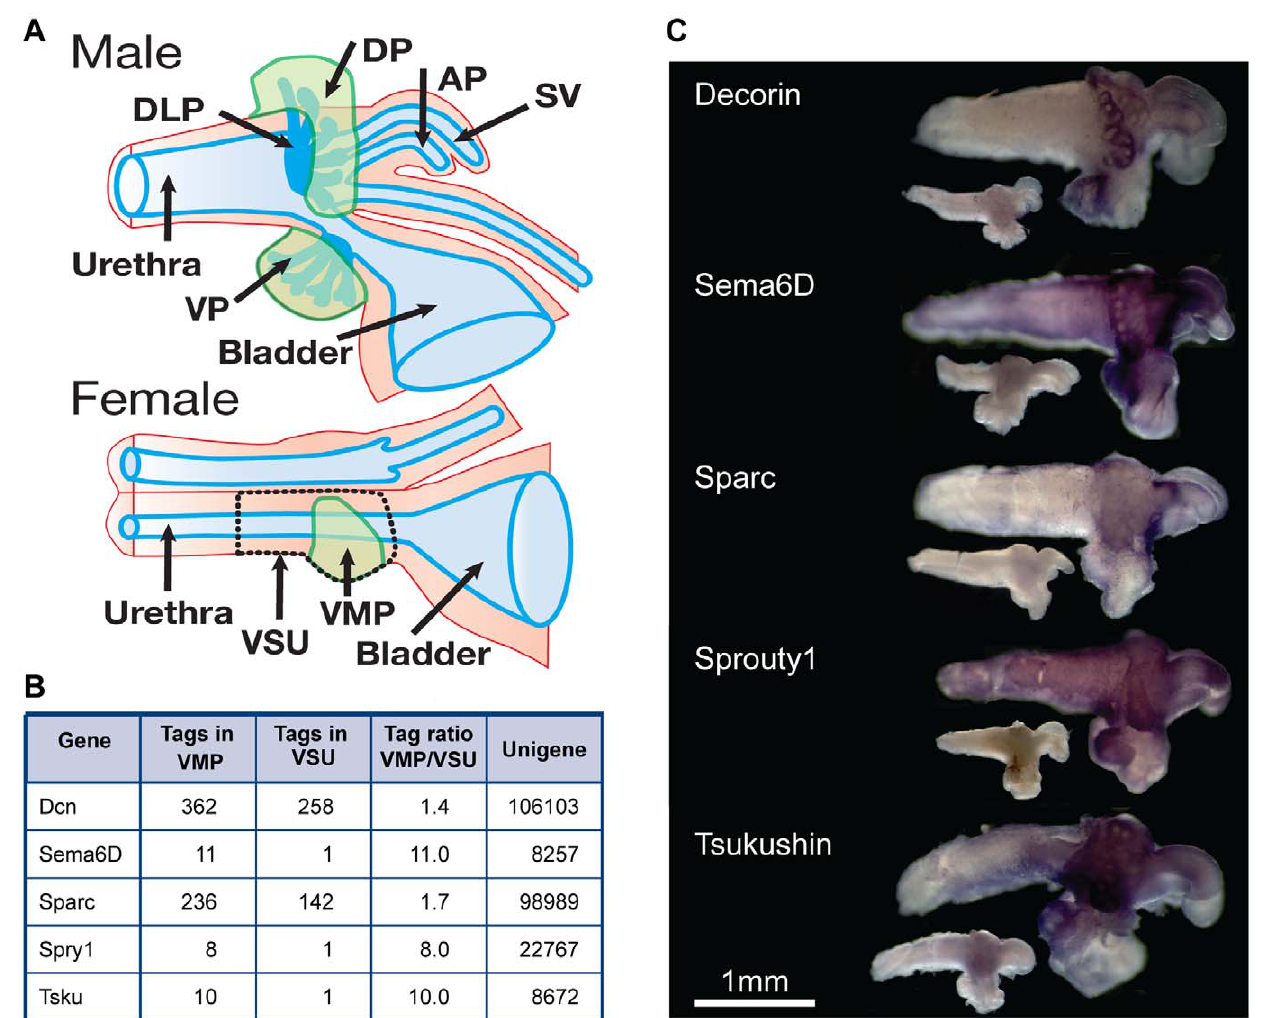
Figure 1. Rat urogenital tract (UGT) anatomy and the expression of Decorin, Tsukushi, Semaphorin6D, SPARC , and Sprouty1 in mesenchyme. A) Schematic overview of rat UGT anatomy at perinatal stage (P0.5) for the male (top) and female (bottom). The green shaded area corresponds to inductive mesenchyme, which is found in both, male and female UGTs. The female VMP mesenchyme was used for SAGE gene profiling studies, and our WISH screen aimed to identify those transcripts expressed in male prostate mesenchyme. Figure based on Thomson, 2001 [46]. B) Transcript expression levels of Decorin, Sema6D, SPARC, Spry-1 and Tsku obtained via SAGE profiling of P0.5 female rat VMP [17]. Transcripts were identified via short, transcript-specific sequences called tags and their count reflects the transcript expression level. The ratio between VMP and VSU tag counts represents the likelihood of restriction to the inductive mesenchyme; values at or over 1.4 suggested mesenchyme-specific expression. C) Detection of Decorin, Sema6D, SPARC, Spry-1 and Tsku mRNA distribution via in situ hybridisation in male rat P0.5 UGTs. The small insets show UGTs treated with the negative control sense RNA probes, scale bar is 1 mm Abbreviations: AP anterior prostate, DP dorsal prostate, DLP dorsolateral prostate, VP ventral prostate, VMP ventral mesenchymal pad, VSU; VMP + smooth muscle + urothelium, SV seminal vesicle.